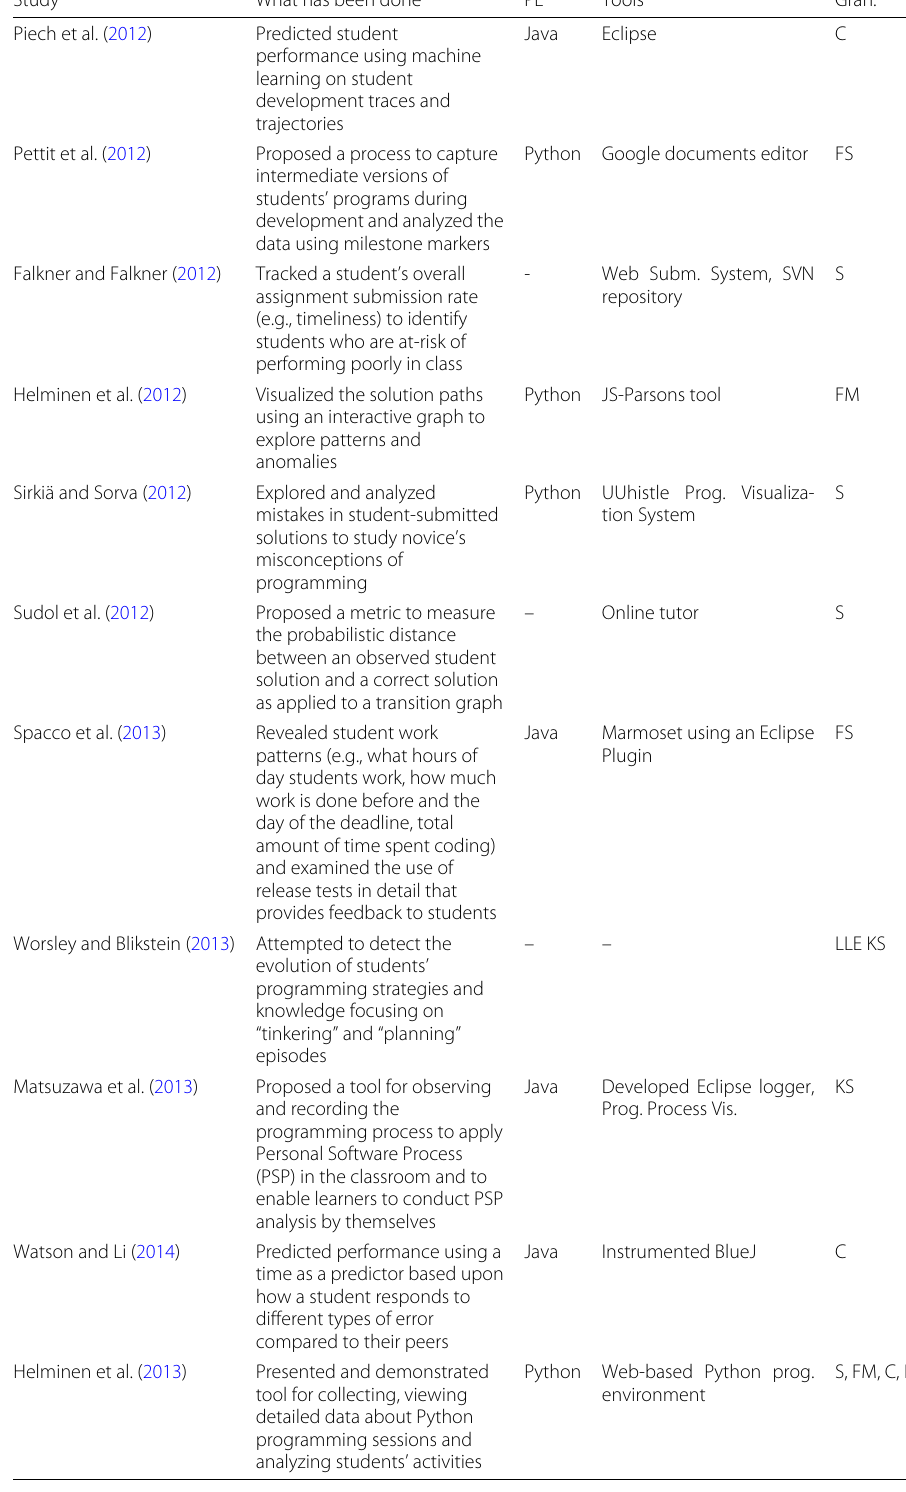
Table 1 Studies conducted using a process-oriented approach in the context of novice programming ( Continued